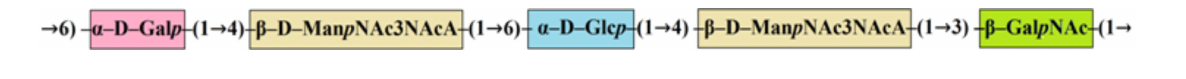
FIGURE 6 | Structure of the polysaccharide of the matrix and cell wall of C. acnes